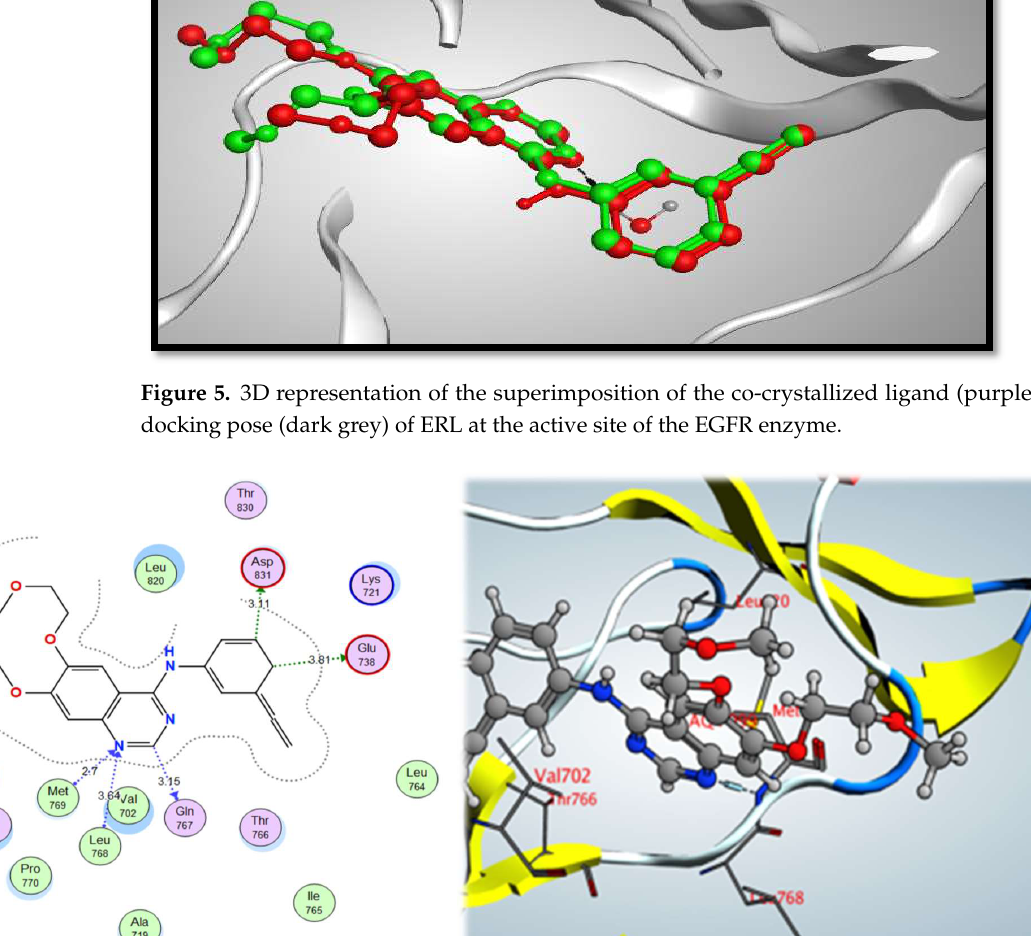
Table 5. Molecular docking results of the most active pyridothienopyrimidine compounds.